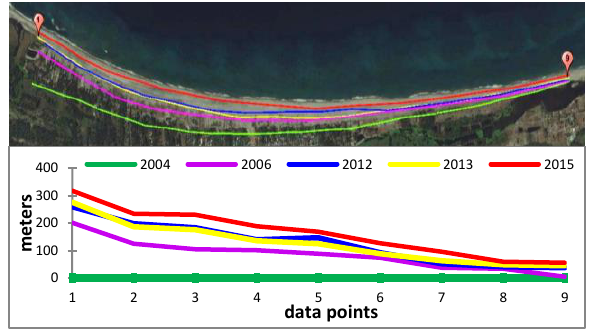
Figure 9. North Coast of Santo Tomas